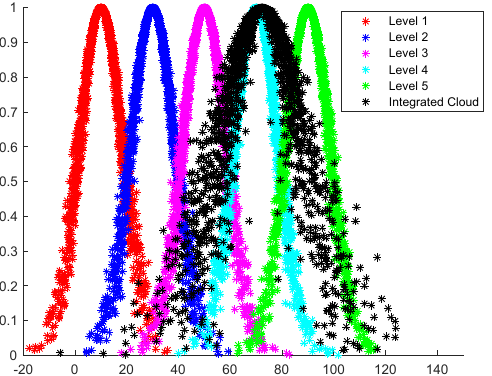
Figure 11. Comparison of bridge construction safety risk integrated cloud and evaluation cloud.